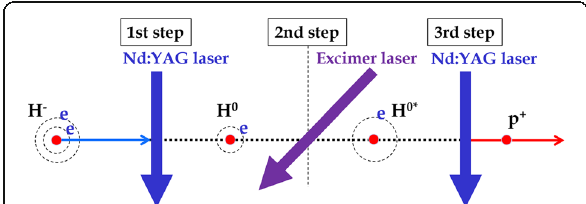
beam before stripping (blue) and for the proton beam after stripping (red), measured with a beam current monitor [53]